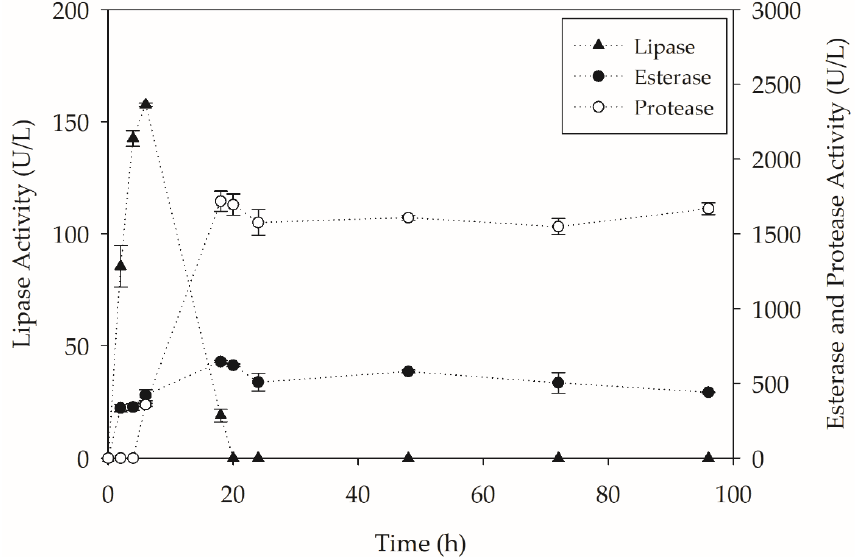
Figure 10. Enzymes production by Y. lipolytica IMUFRJ 50682 in bioreactors (450 rpm, 1 vvm and 28 °C) containing YT medium + PC-PET (500 mg/L) over 96 h.